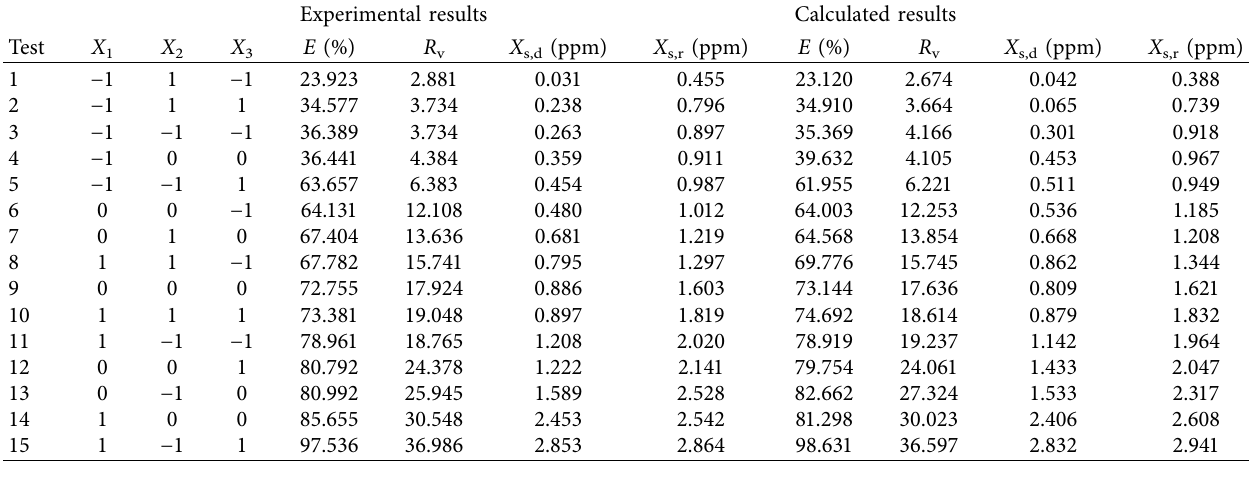
Table 2: Experimental results for optimization of RB-5 dye (25ppm, 50ppm, and 75ppm) with TX-114 at various operating temperatures (40 ° C, 50 ° C, and 60 ° C).